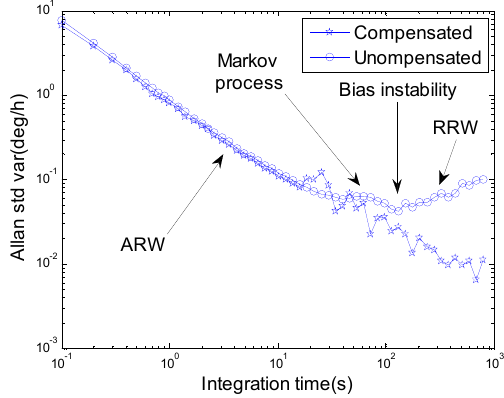
Figure 4. Allan variance of compensated and uncompensated data of the equivalent east gyroscope.